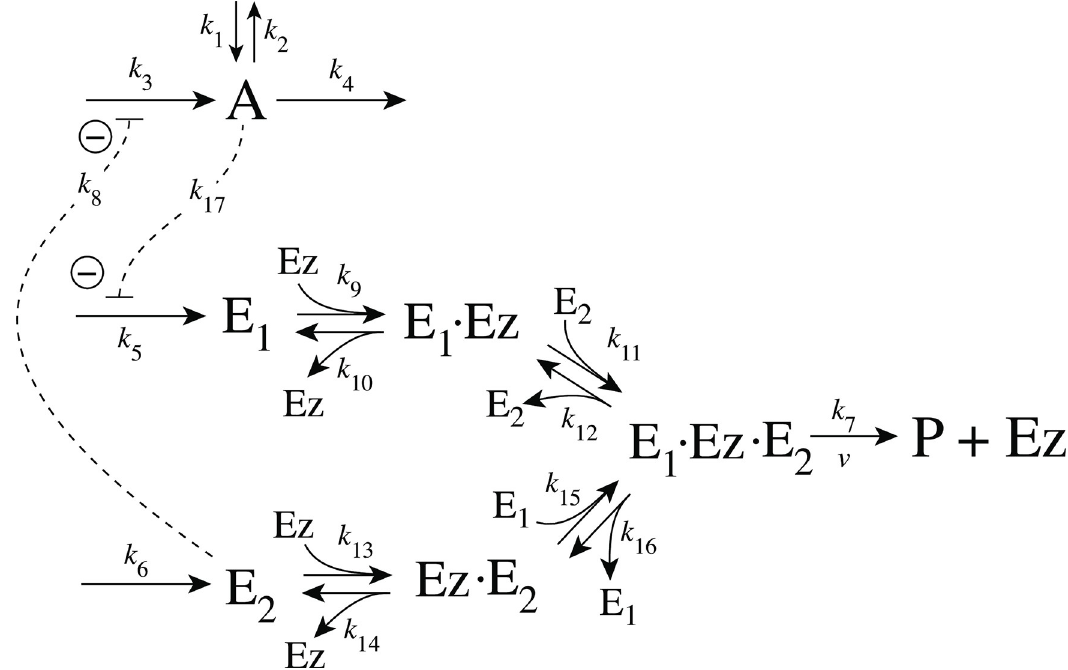
Fig 19. Motif 4 dual-E/antithetic controller using an enzymatic random-order ternary-complex mechanism for the removal of E 1 and E 2